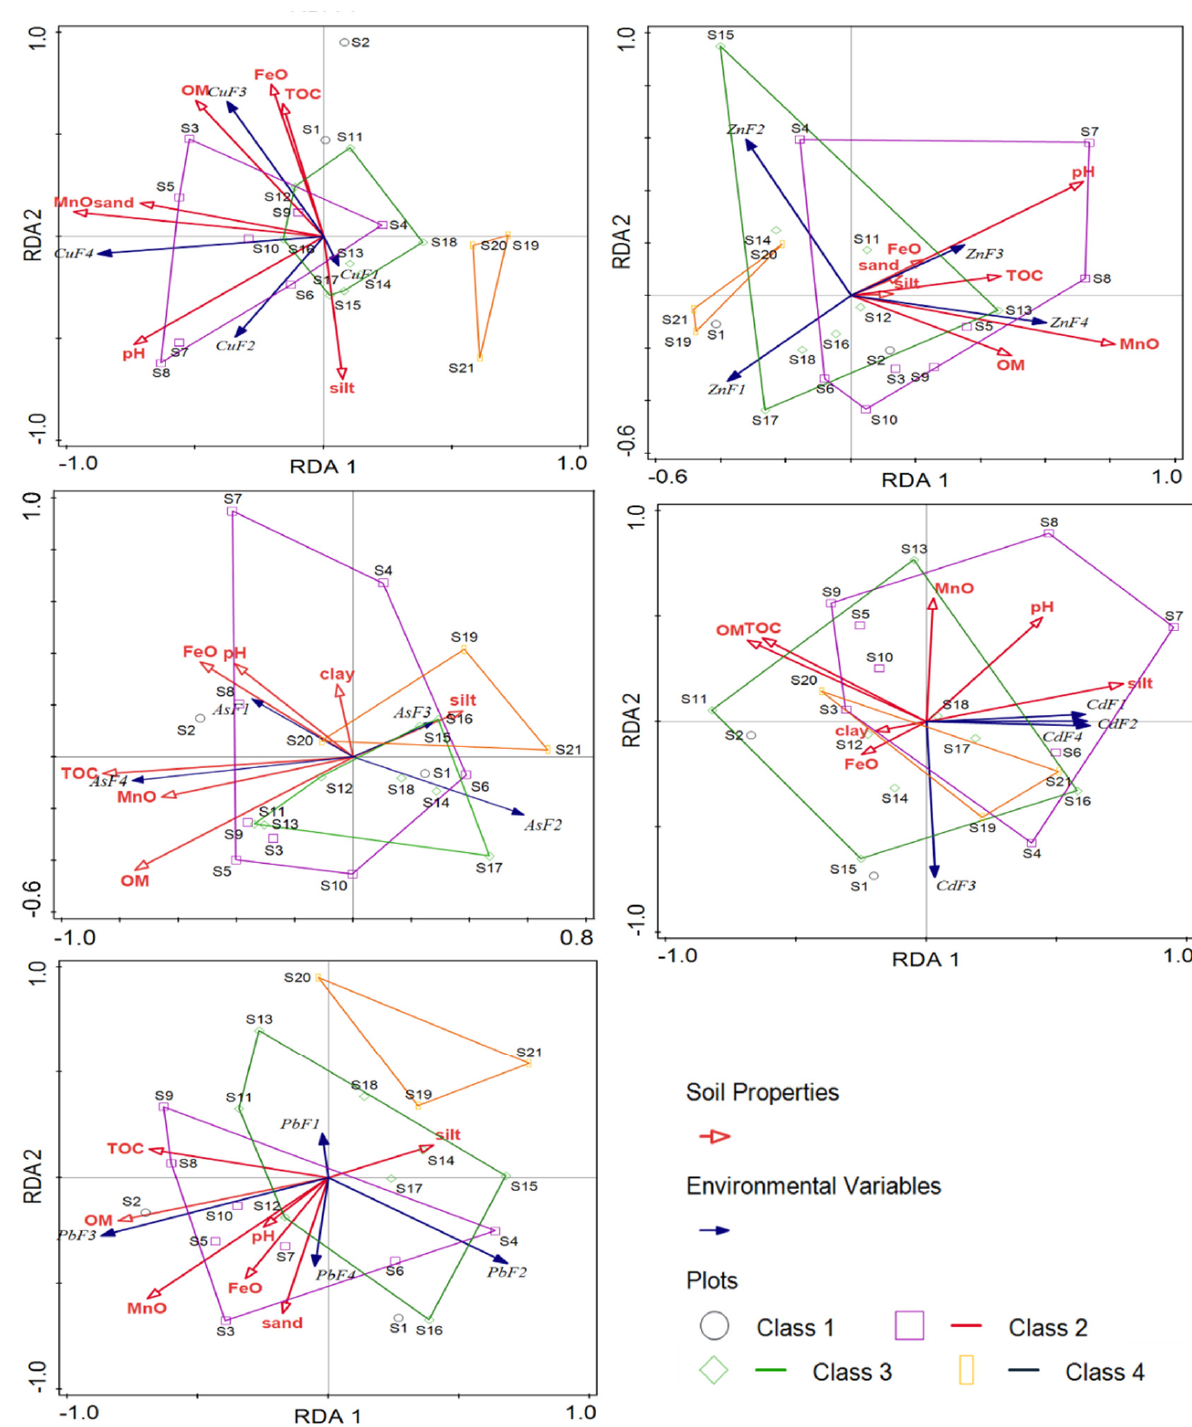
Figure 5. RDA of fractional contents of PTEs associated with sediments physicochemical properties of the Wuliangsuhai wetland (Class 1 — XDT; Class 2 — NEA; Class 3 — MDP; Class 4 — FCA) .